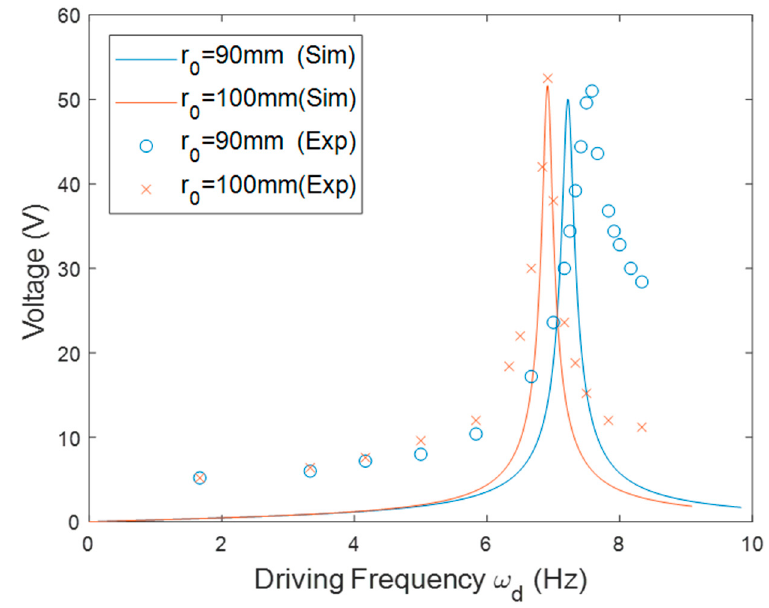
Figure 8. The simulation and experimental voltage responses of the PEH in the inward orientation with different r 0 .